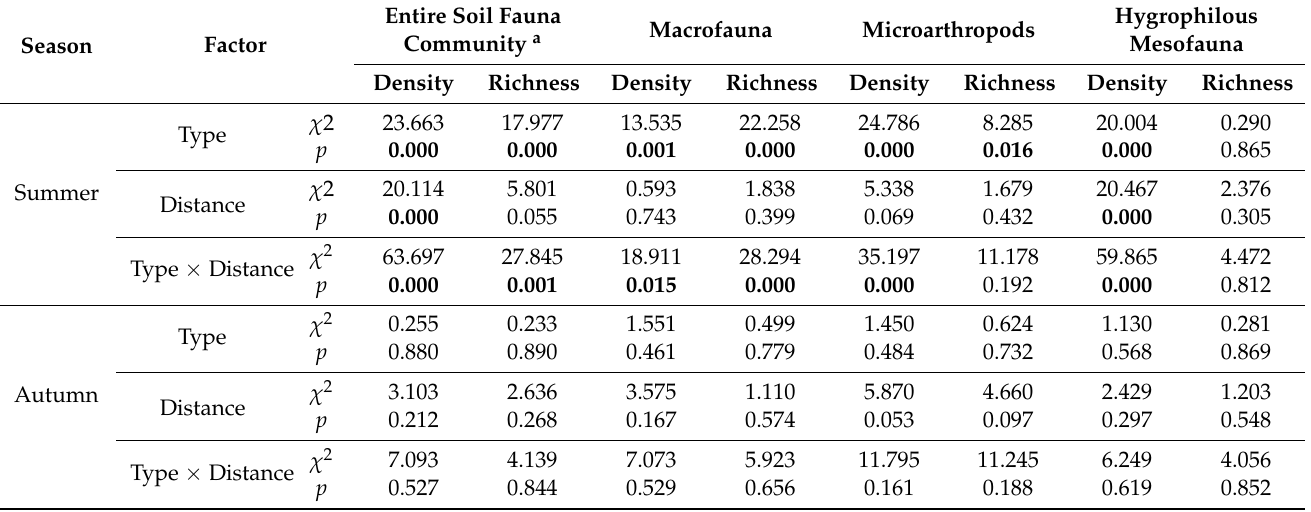
Table 1. Results of testing for the effects of revetment type, distance, and their interactions on soil fauna abundance and richness. χ 2 statistics for the likelihood ratio test and p values are